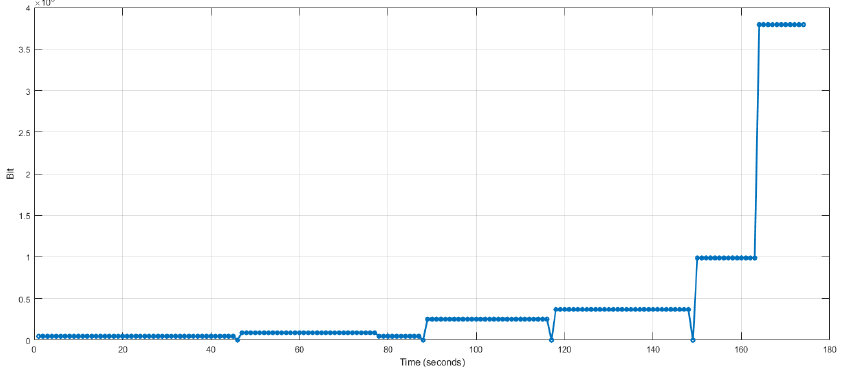
Figure 7. Results of resolution network feature experimentation trials.